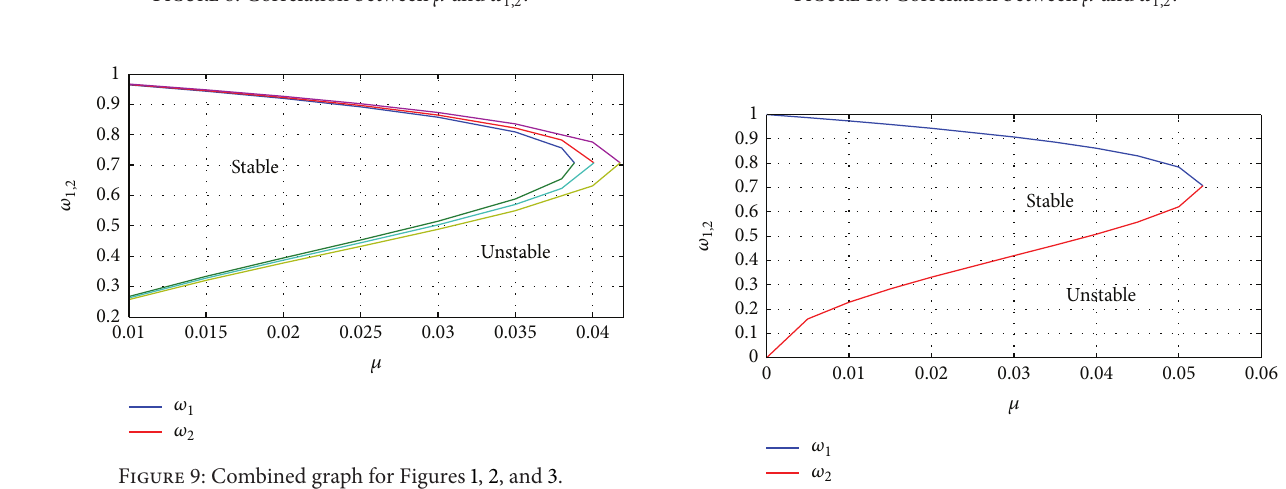
Figure 8: Correlation between 𝜇 and 𝜔 1,2 .